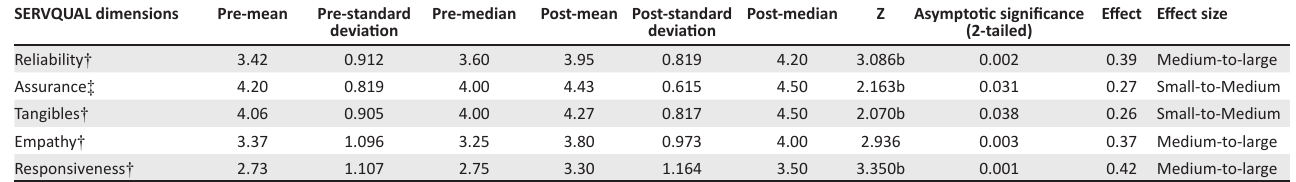
TABLE 5: Customers’ pre- and post-perceptions and test statistics. SERVQUAL